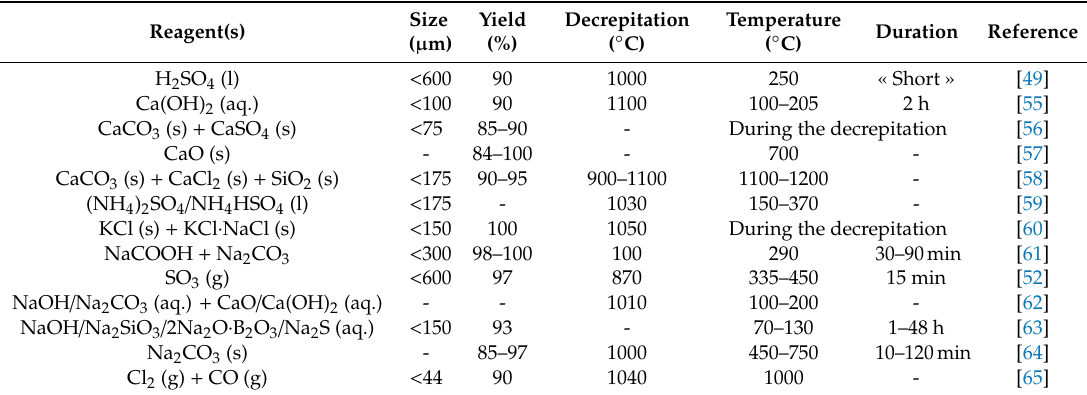
Table 4. Patented processes of lithium extraction from spodumene